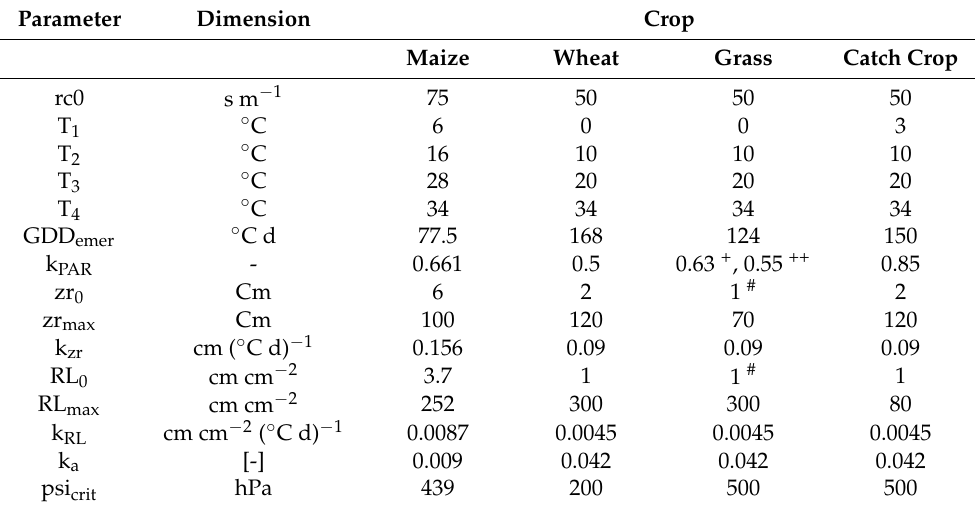
Table 2. Crop parameters, their units and values, as used in the model analysis. Parameter Dimension Crop